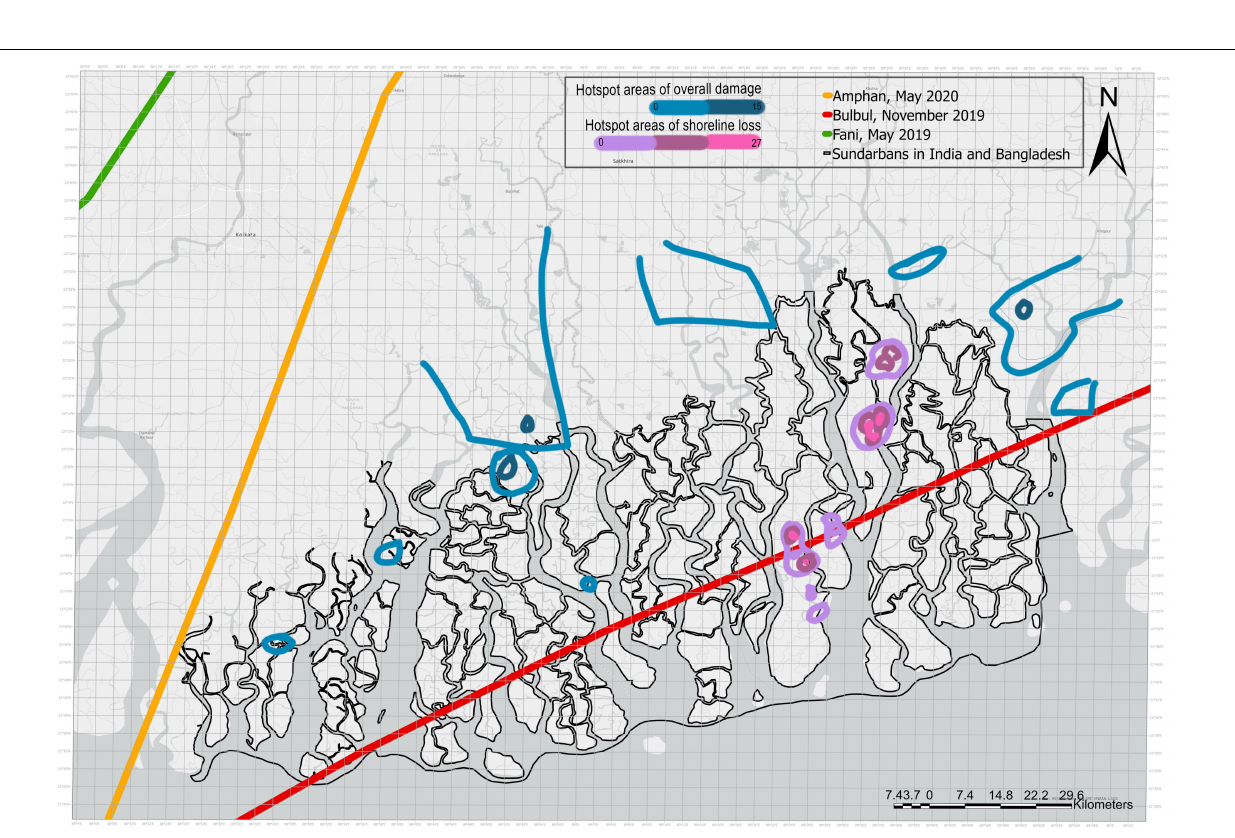
Frontiers in Marine Science |